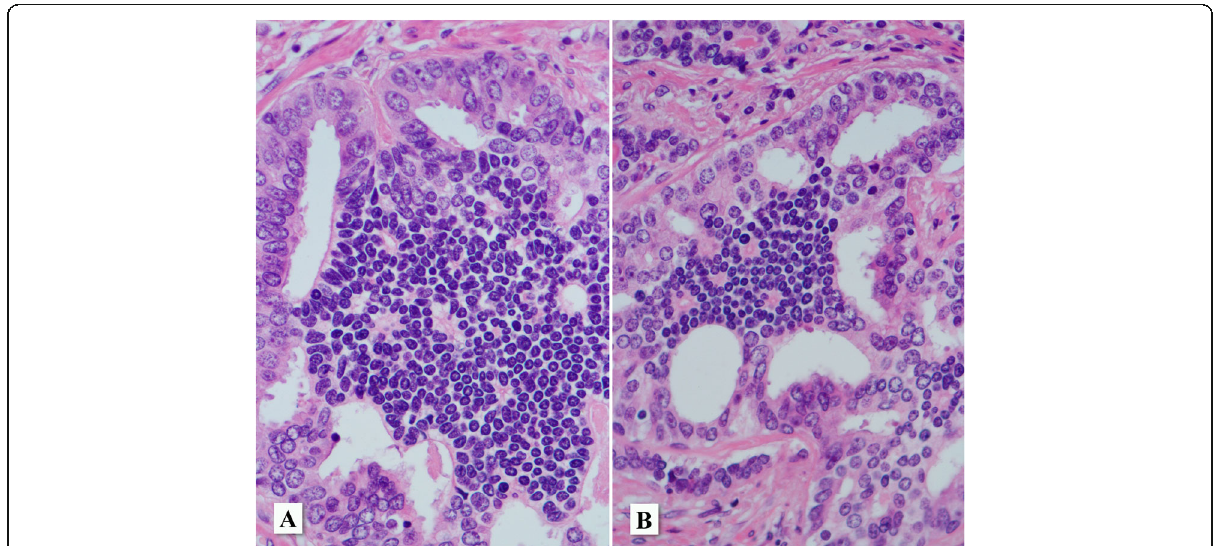
Fig. 2 Other examples of small cell-like change in intraductal carcinoma. Aggregates of small cells in the center of the lesion show occasional lumen and rosette formation. A and B (Hematoxylin and eosin stain,